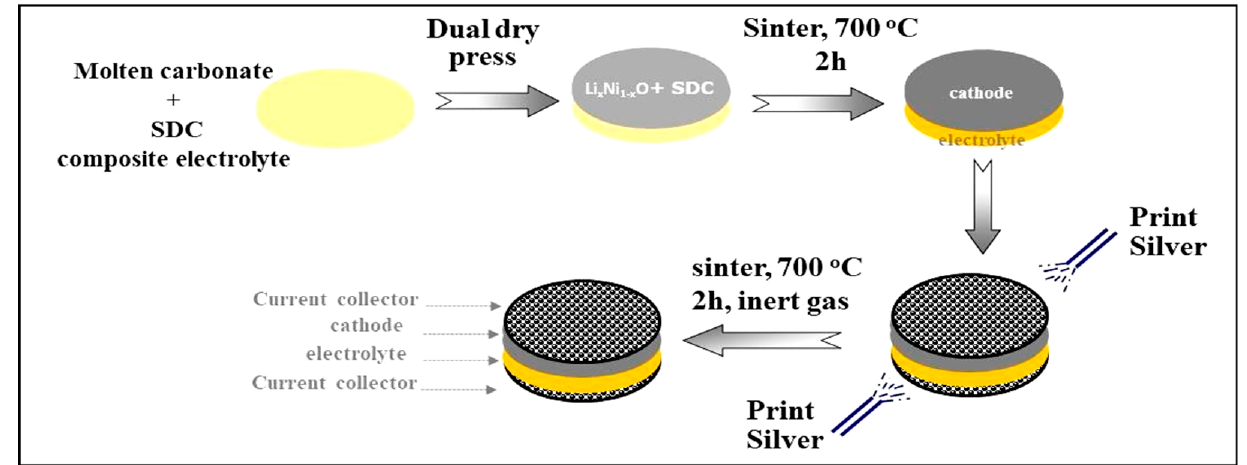
Figure 2. Experimental protocol of DCFC pellet preparation.